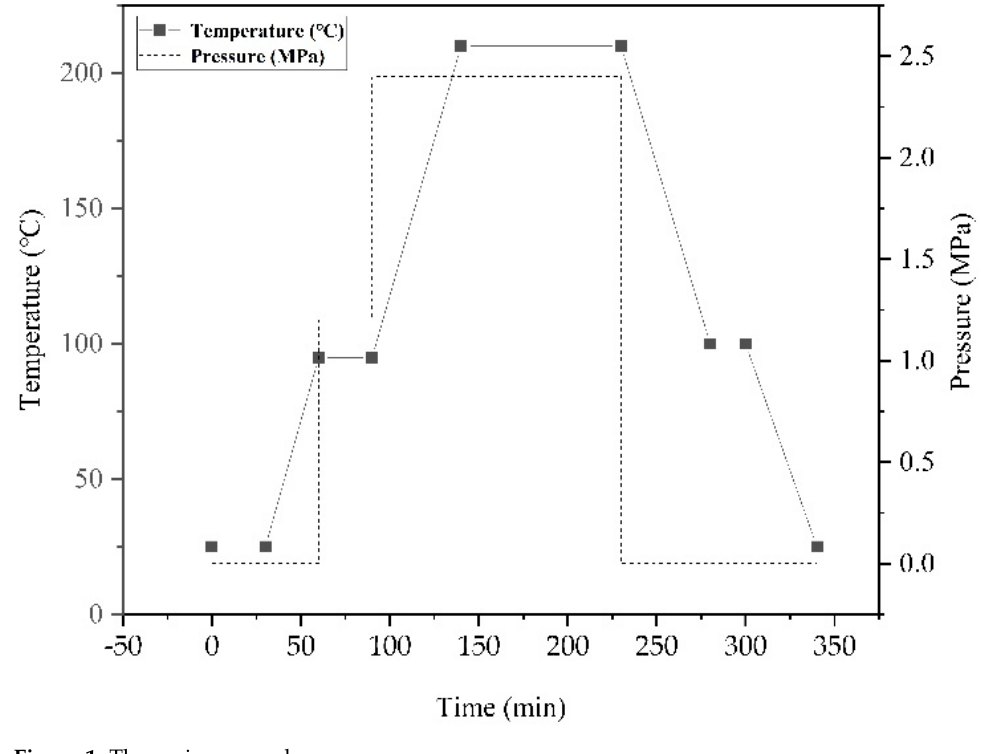
Figure 1. The curing procedure.